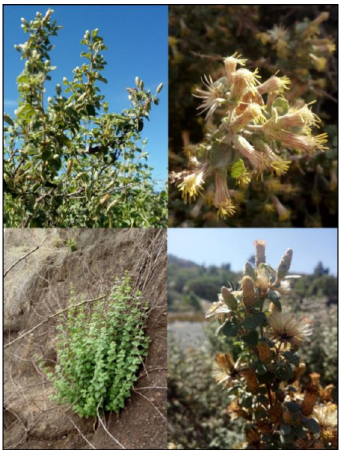
Figure 1. Brickellia veronicifolia in wild